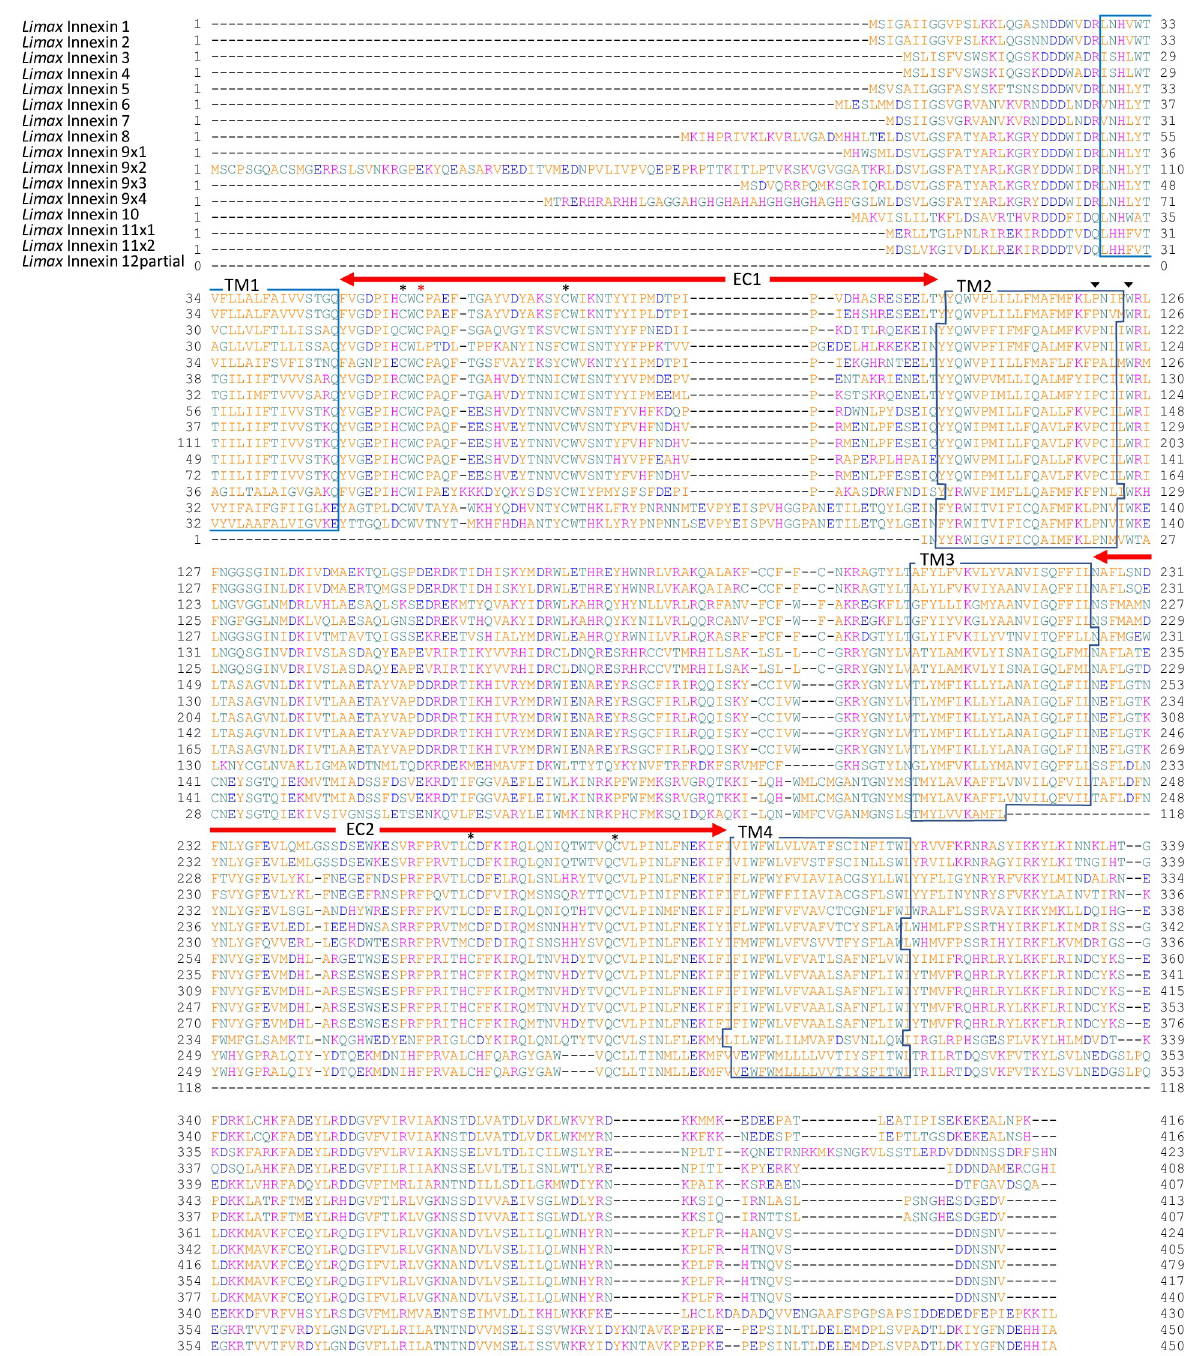
Fig 1. Limax innexin transcripts expressed in the central nervous system. Alignment of deduced amino acid sequences of the Limax innexin homologs identified in the transcriptome of the central nervous system. Limax innexin 9 and 11 had transcript variants: Limax innexin 9x1-9x4 and Limax innexin 11x1-11x2. The boxes show the four predicted transmembrane domains (TM1 to TM4), while the red arrows indicate two extracellular loops (EC1 and EC2). The black asterisks indicate the extracellular cysteine residues in the extracellular loops, while the red asterisk indicates the additional cysteine residue. The black arrow-heads indicate the P-X-X-X-W motif.